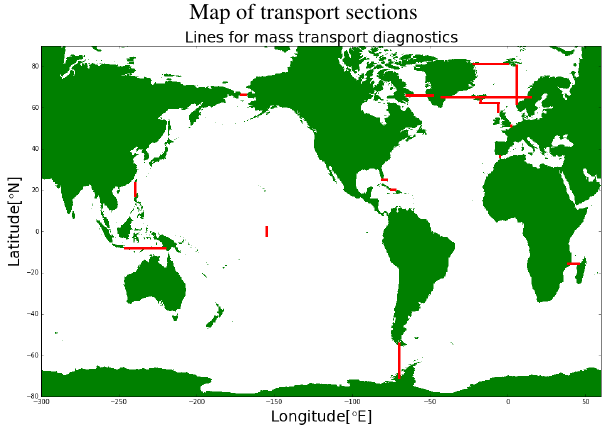
Figure J1. Map of sections through which mass transport is re- quested for CMIP6 simulations. This map is generated for a particu- lar model configuration used at GFDL. A similar map is relevant for any other model configuration, with the possibility that some mod- els may be too coarse to resolve all of the sections. Note the zig-zag path for the faroe_scotland_channel, which arises since there is no single grid line that crosses this section. Such zig-zag lines are a function of the particular model